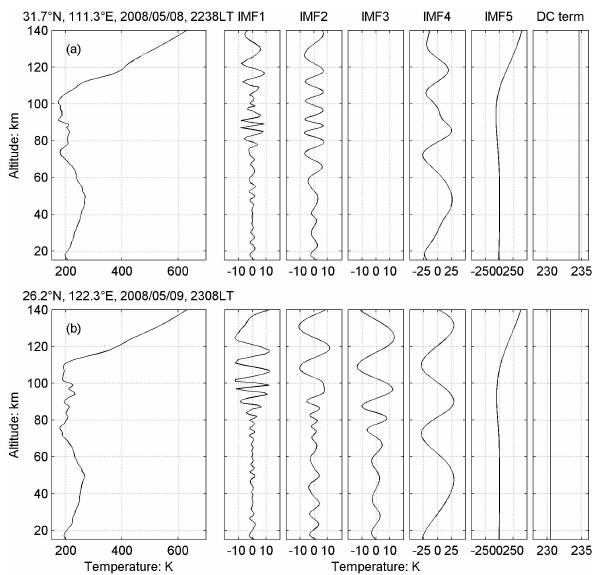
Fig. 4. Examples of the IMFs which decomposed from the individ- ual Tn profiles using EMD. (a) A case without the IMF3 component and (b) a case with the IMF3 component.